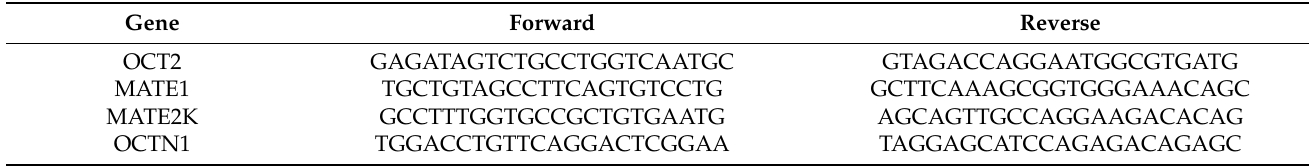
Table 1. Primer sequence for each gene